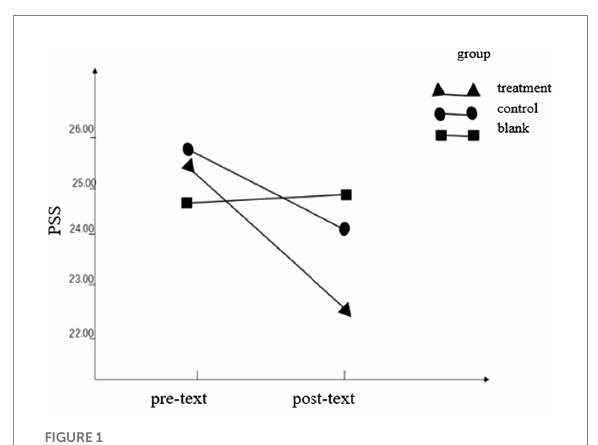
FIGURE 1 Pre- and post-text outcome of